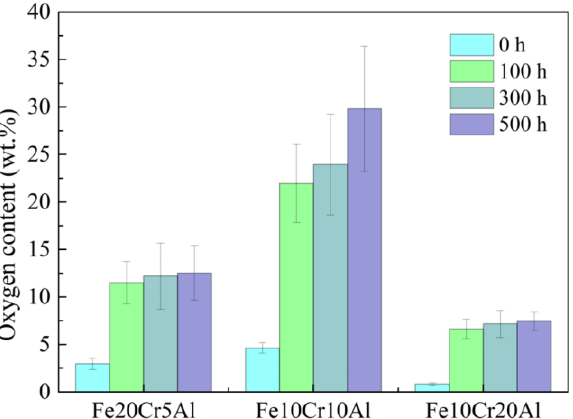
Figure 7. Oxygen content of the aged porous Fe-Cr-Al materials determined by EDS.